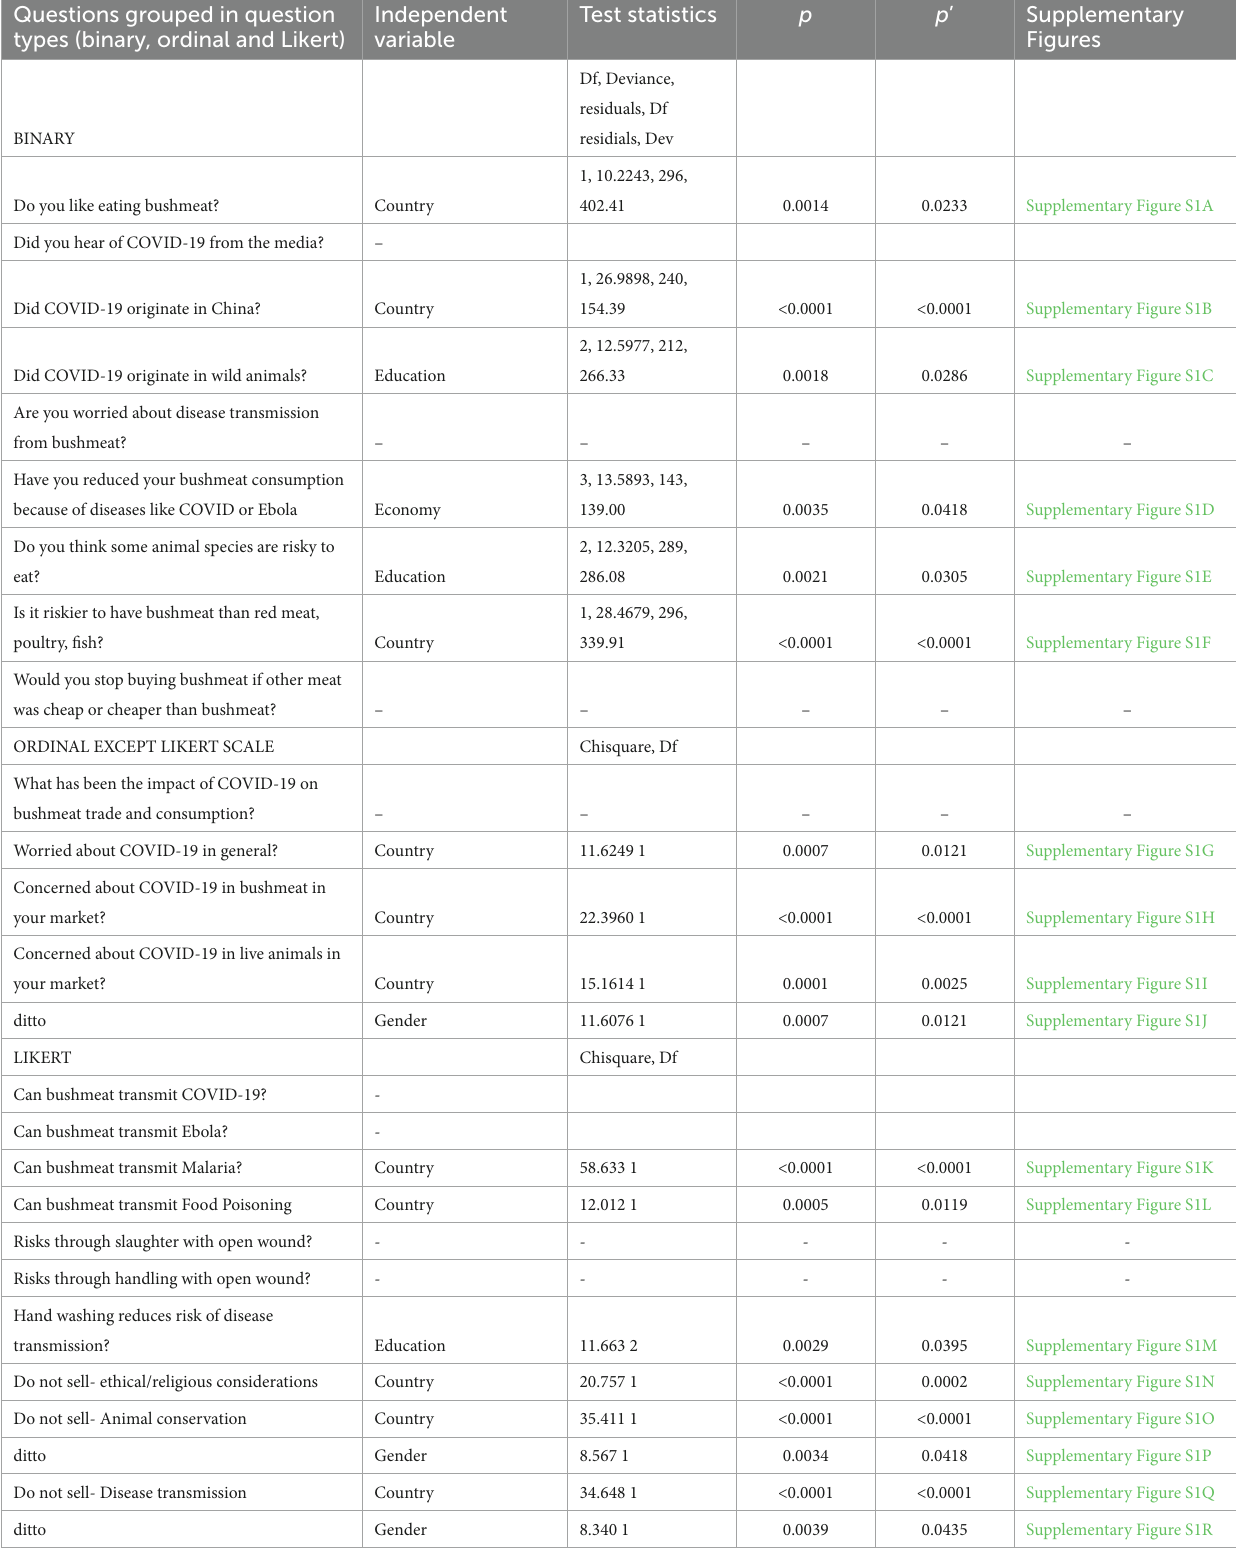
TABLE 1 Summary statistics for all 23